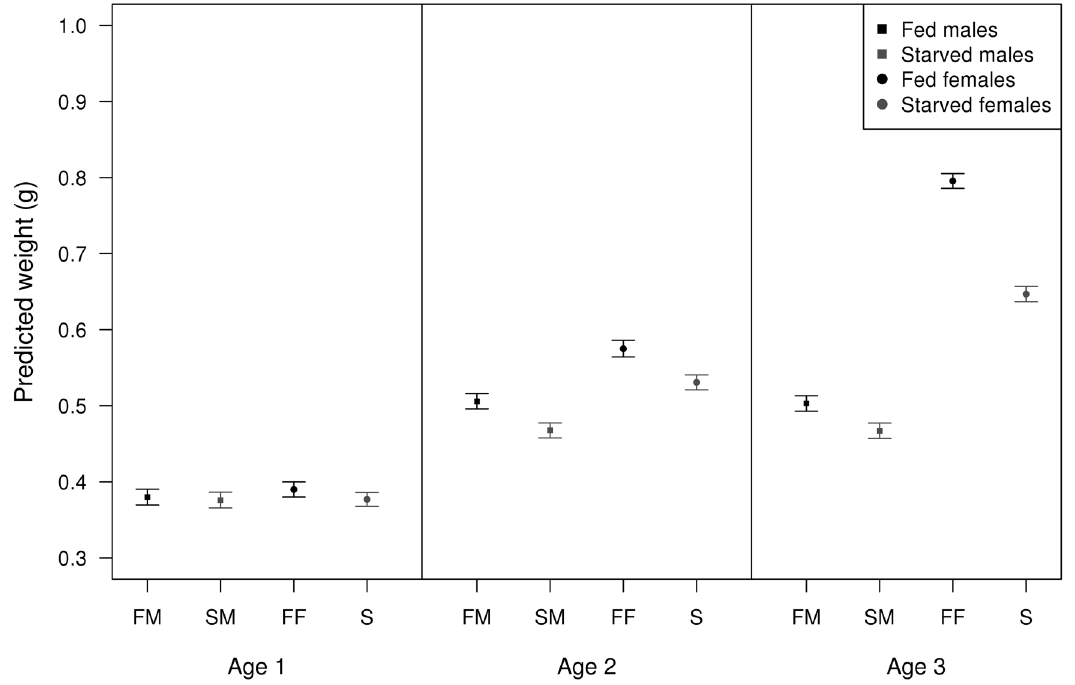
Figure 6. Resource allocation in abdominal weight in both sexes. Predicted abdominal weight (in g) of adult damselflies according to food treatment, sex and age. Error bars show 95% confidence intervals. doi:10.1371/journal.pone.0076246.g006 PLOS ONE |